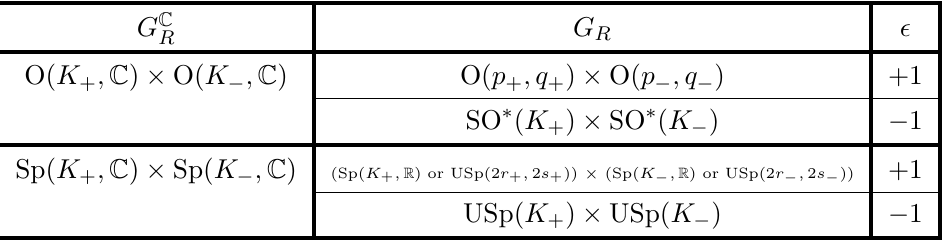
+ q = K and 2 r + 2 s = K . The last column shows which type of ± ± ± ± ± ±